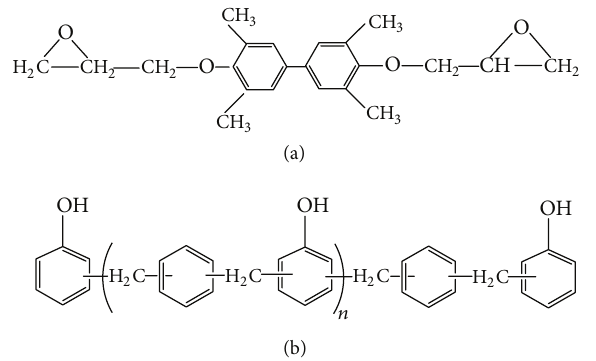
Scheme 1: The chemical structure of the (a) 4,4 󸀠 -diglycidyloxy- 3,3 󸀠 ,5,5 󸀠 -tetramethyl biphenyl epoxy and (b) phenol-aralkyl resin.